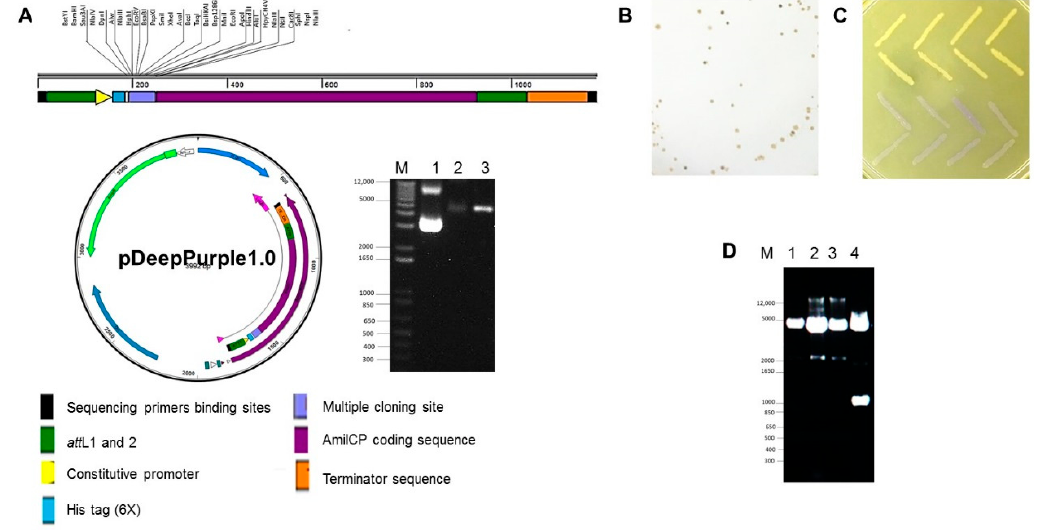
Figure 2. Cloning plasmid pDeepPurple1.0 is functional for cloning applications. Panel ( A ), Plasmid map showing all the restriction sites contained in the multiple cloning site. Also, corroboration of plasmid integrity by restriction analysis using two sites of the multiple cloning site. M, size marker, 1, undigested plasmid; 2, BamHI digested plasmid and 3, XhoI digested plasmid. Panels ( B , C ), colonies obtained from the cloning of a 2 and 1 kb fragments from the 1 kb DNA ladder from Invitrogen, cloned into EcoRV restriction site. Panel ( D ), plasmid analysis: lane 1, blue-purple colony, lane 2 and 3, white colonies from the cloning of the 2 kb ladder band and lane 4, white colonies from the cloning of the 1 kb ladder band. M, 1 kb DNA ladder (Invitrogen). The analysis was done using BamHI-HindIII digestion.